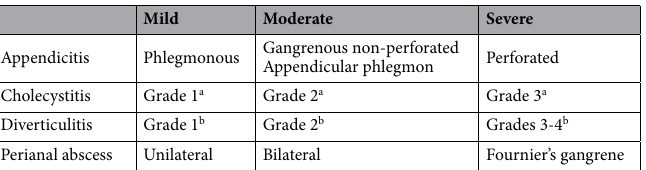
Table 1. Severity classification of acute surgical inflammatory processes. a Modified Hinchey Classification 8 . b Tokyo Guidelines 2018 9